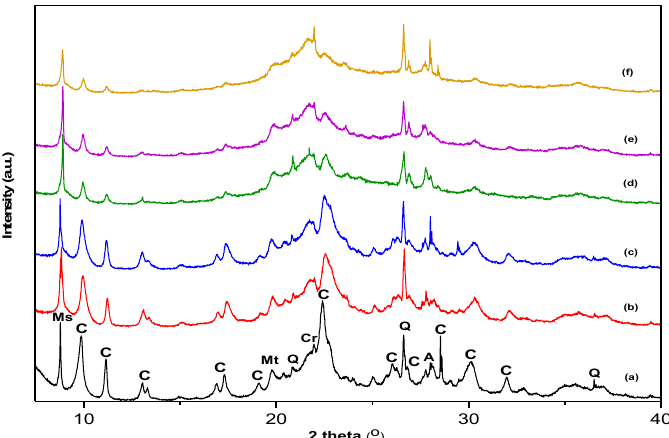
Figure 1. The powder X-ray di ff raction (pXRD) patterns of (a) raw zeolite (RZ), (b) zeolite thermally treated at 450 ◦ C, (c) zeolite thermally treated at 500 ◦ C, (d) zeolite thermally treated at 600 ◦ C, (e) zeolite thermally treated at 750 ◦ C, and (f) zeolite thermally treated at 800 ◦ C. Note: clinoptilolite, C; muscovite, Ms; quartz, Q; montmorillonite, Mt; cristobalite, Cr; albite,